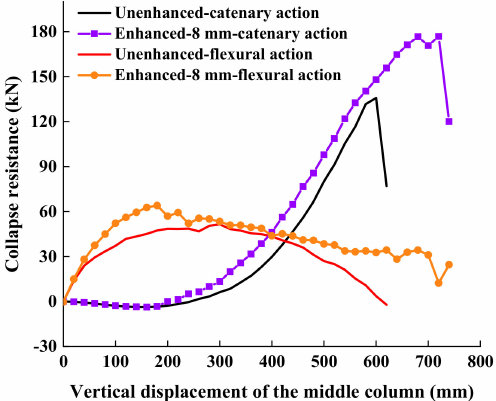
Figure 17. Collapse resistance mechanisms of model